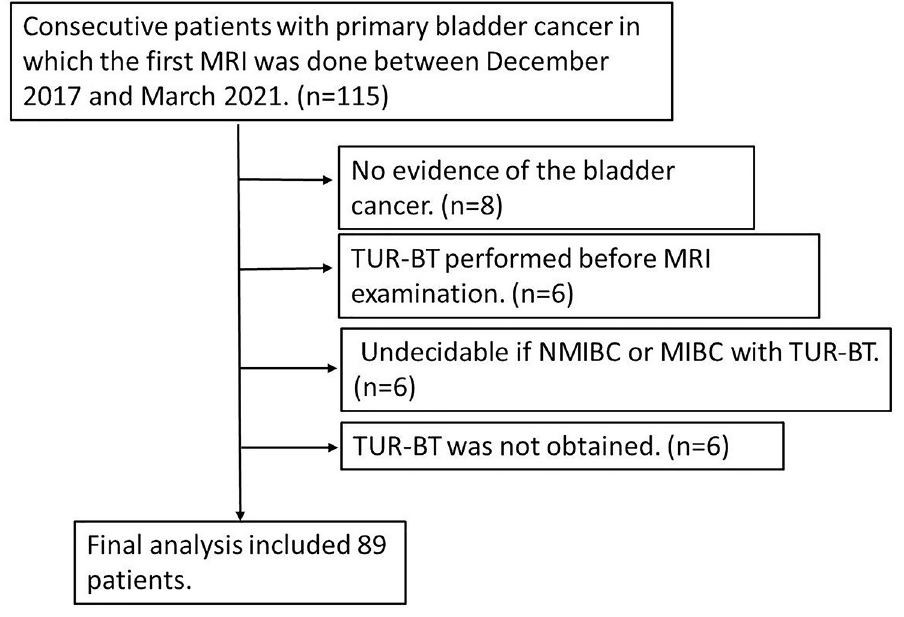
Fig 1. Flow diagram of the selection of patients.